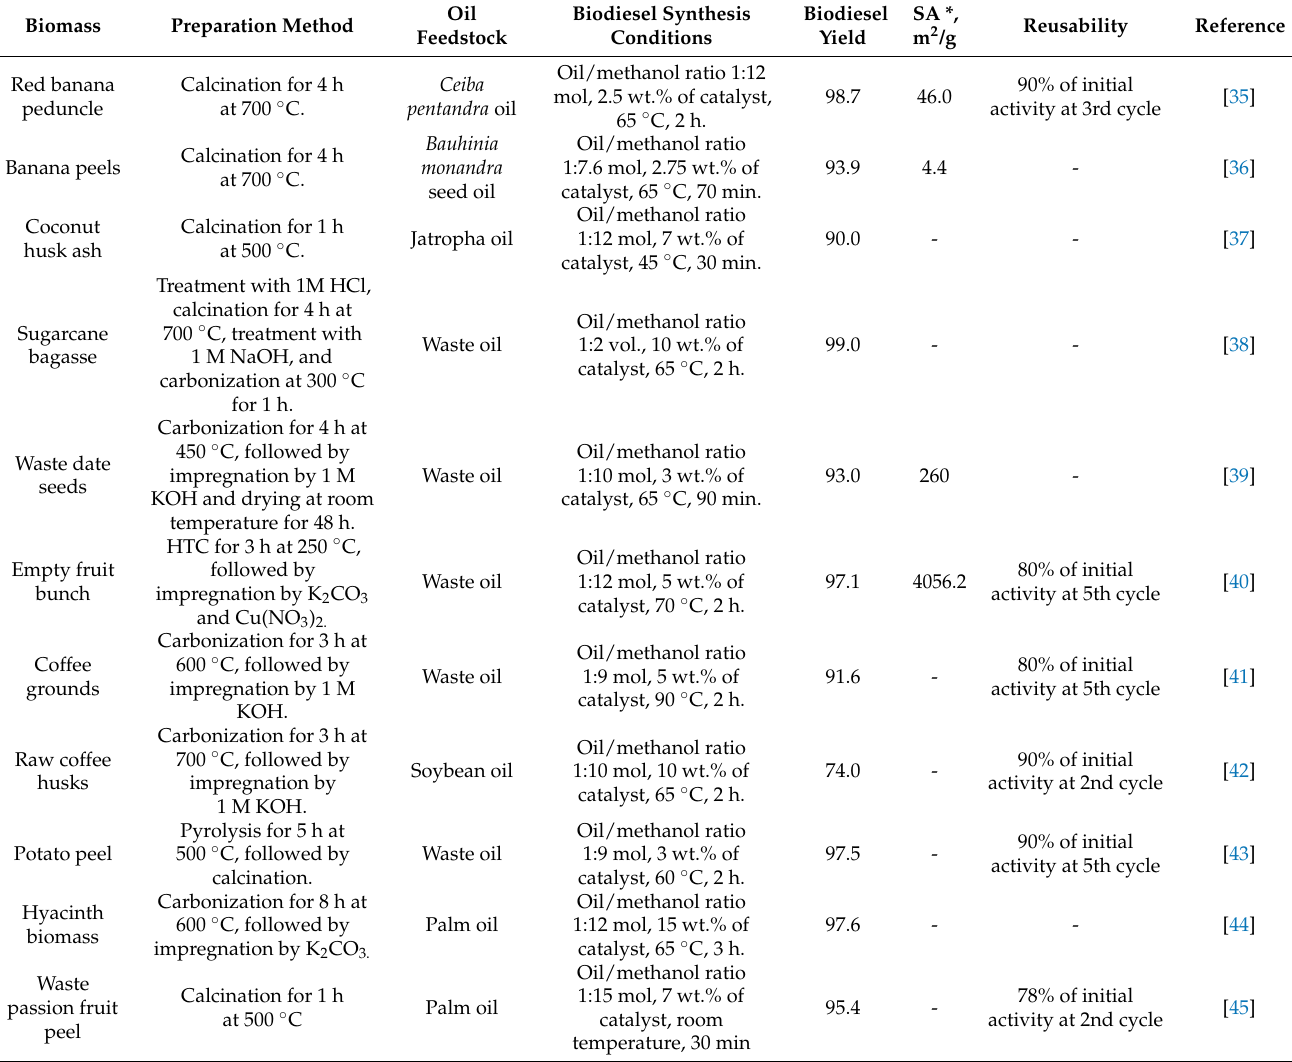
Table 2. Basic carbon-based catalysts for biodiesel